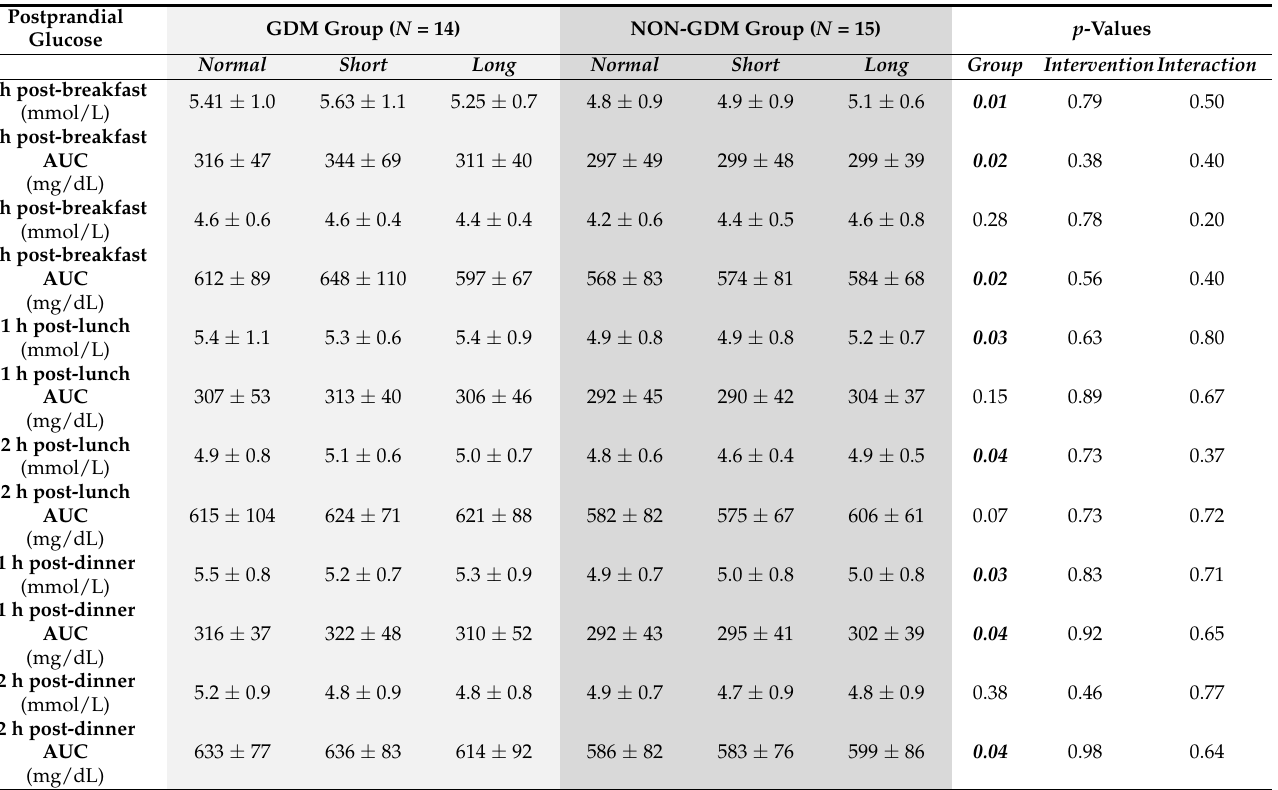
Table 3. 1 h and 2 h postprandial glucose values in women with and without GDM across three